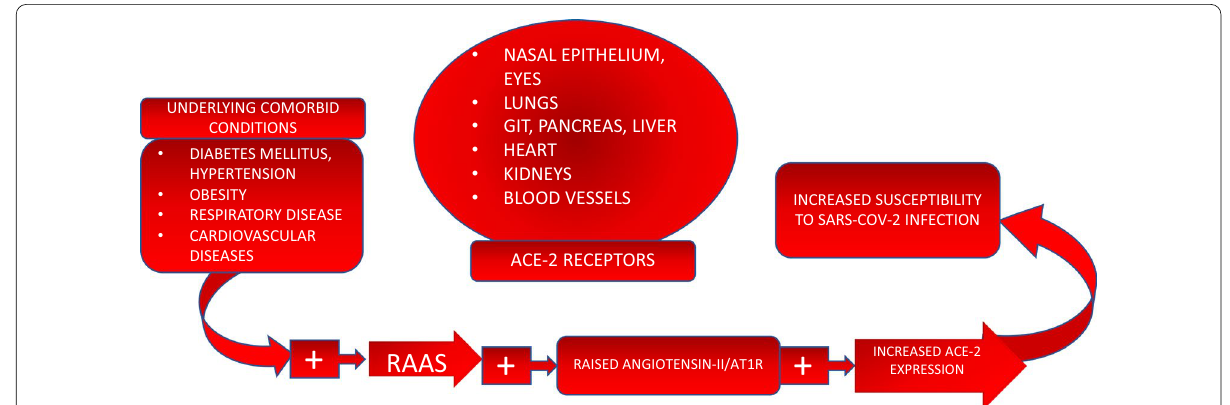
Fig. 2 Distribution of ACE-2 receptors and underlying co-morbid